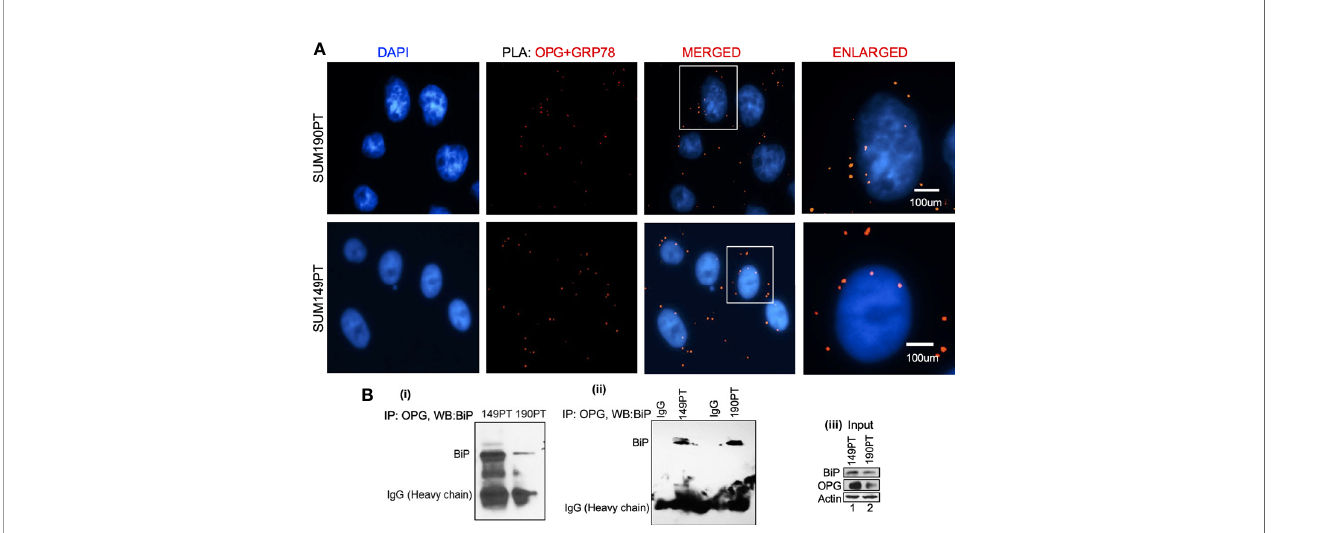
FIGURE 2 | OPG interacts with BiP/GRP78 in IBC cell lines. (A) Proximity ligation assay (PLA) was performed using IBC cell lines, SUM149PT, and SUM190PT. Cells were fi xed, permeabilized, and incubated with primary antibodies against OPG and BiP/GRP78, and then labeled with DuoLink PLA plus and minus probes. A red fl uorescent probe was used to detect ampli fi ed DNA. Nuclei were visualized using DAPI as the counterstain (blue). (B) Association of OPG and GRP78 in IBC cell lines. Co-immunoprecipitation of OPG-BiP/GRP78 complex using anti-OPG antibody or anti-IgG antibody and visualization of the complex via Western blotting using anti- BiP/GRP78